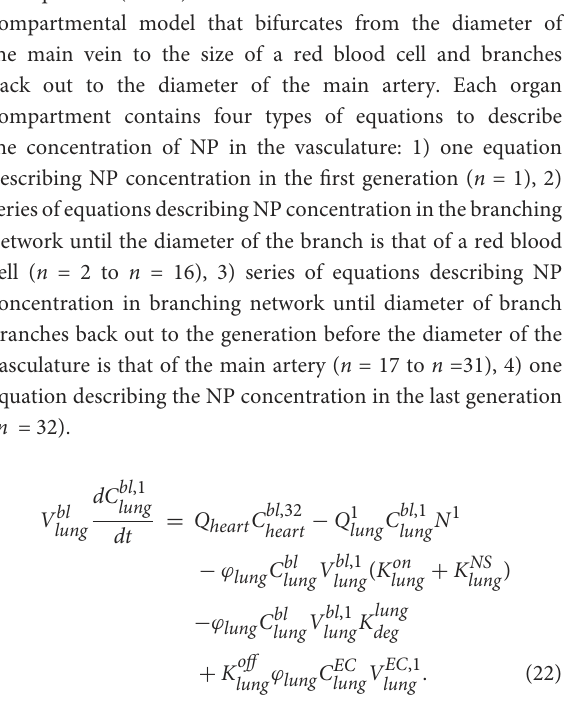
and 32 generations of branching for each branching element.